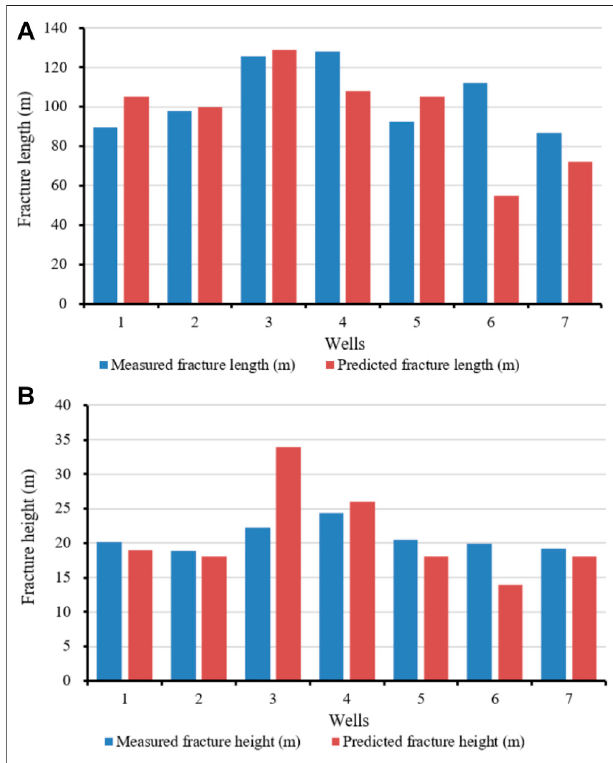
FIGURE 5 | Comparison of hydraulic fracture parameters for fracturing simulation and microseismic monitoring. (A) Distribution of fracture length; (B) Distribution of fracture height.